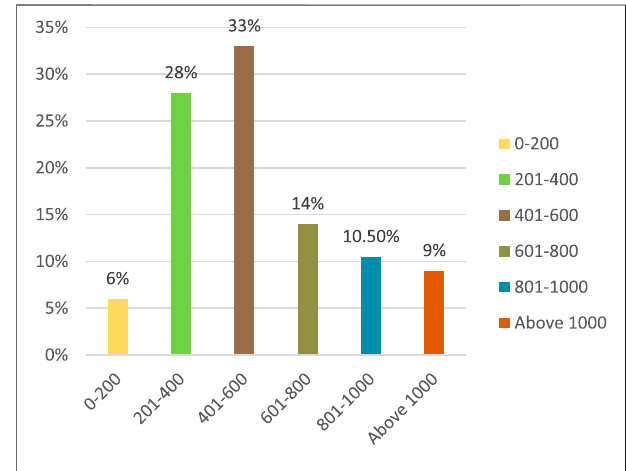
FIGURE 5 | Household monthly average energy